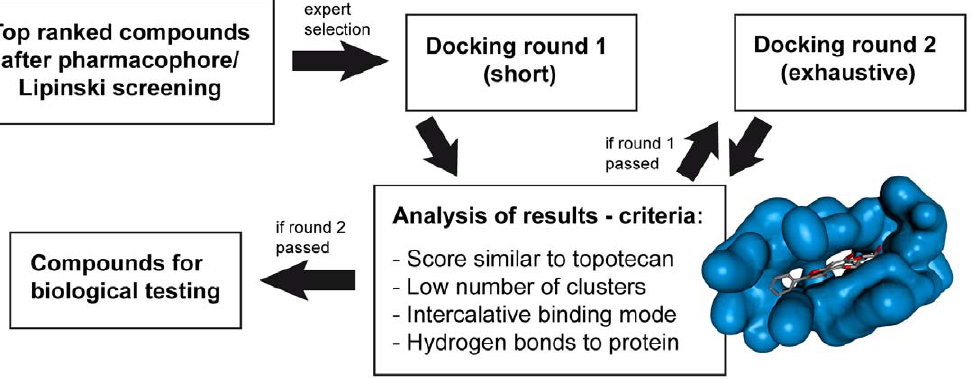
Figure 4. Selection of compounds for biological testing. Overview of the procedure used to select compounds for biological testing. See text for details.